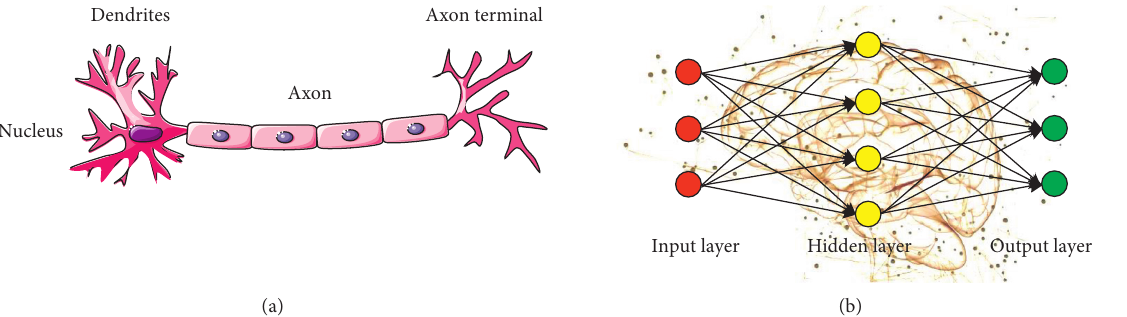
Figure 1: Structure diagram of three-layer BP neural network: (a) neural cell structure; (b) BP neural network.